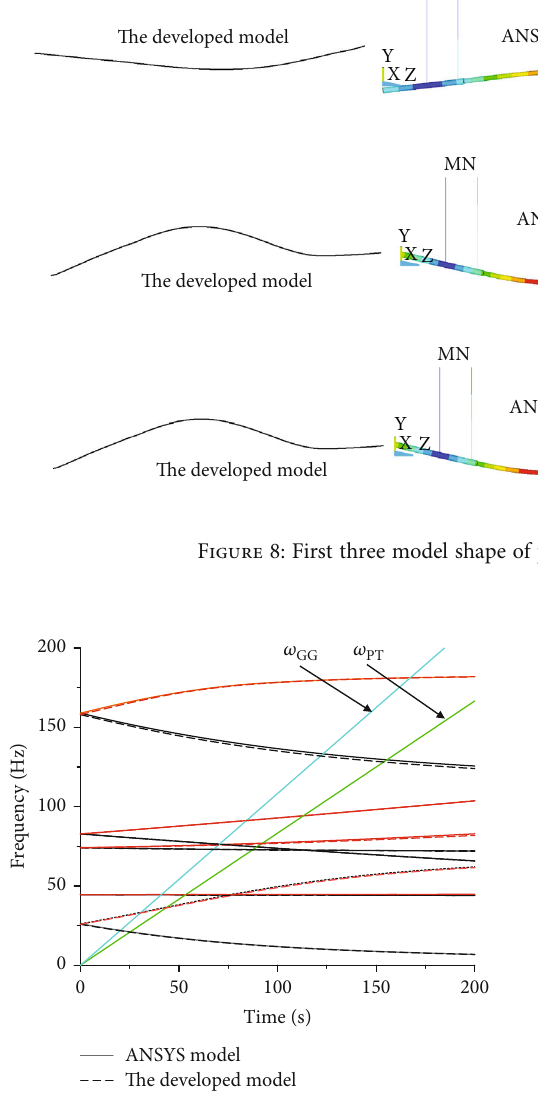
Figure 9: Campbell diagram of a